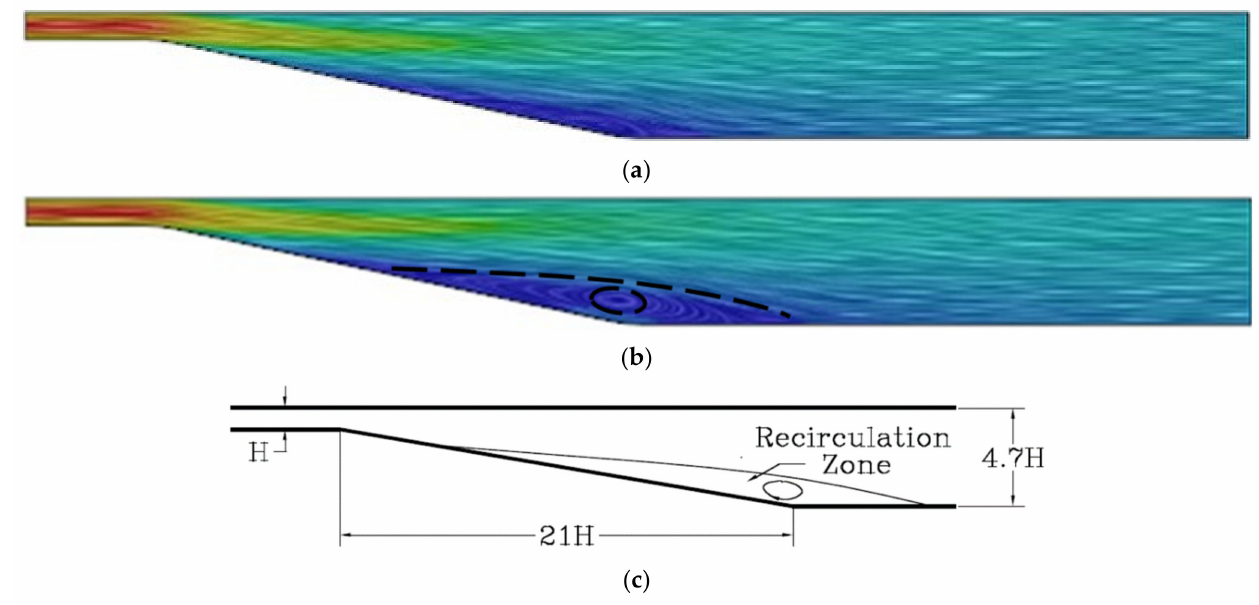
Figure 4. Comparison of streamline distributions for the asymmetric diffuser obtained from ( a ) the RKE model, ( b ) the STRUCT- ε model and ( c ) the experimental observation [34] where red and blue colors represent high and low magnitude of the velocity